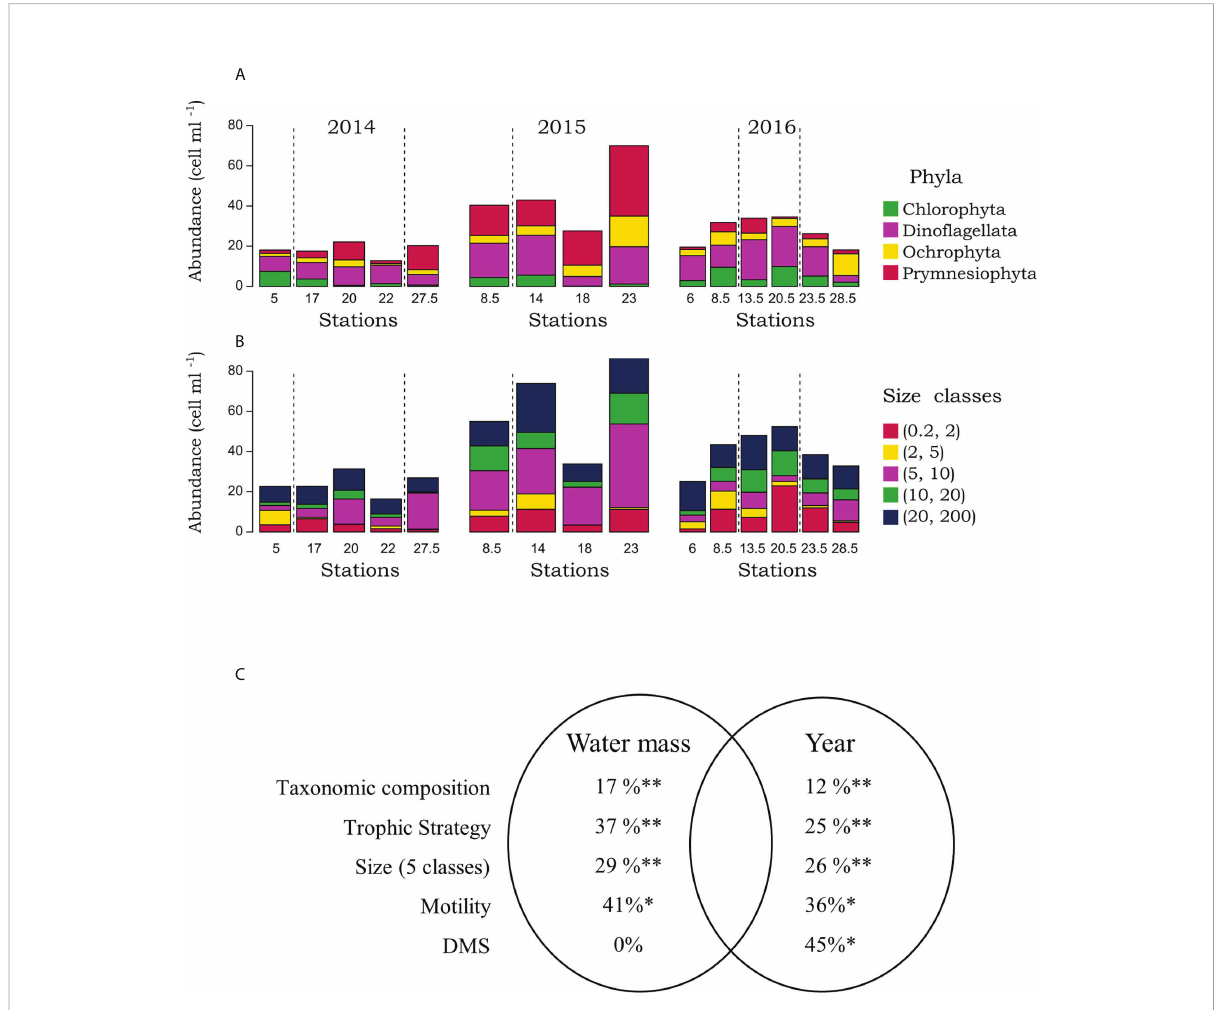
FIGURE 1 The abundance of the most abundant taxa based on 18S sequencing (A) , and size classes (B) in the Labrador Sea water masses and over years. Dashed lines represent the separation between waters masses: Labrador shelf (left), central basin (middle), Greenland shelf (right, absent in 2015). A Venn diagram (C) representing the variation partitioning (in %) of taxonomic composition and the four functional traits of this study across water masses and years. Note that nothing was shared between space and time. * and ** represent partial RDA p-values of ≤ 0.05 and ≤ 0.01,